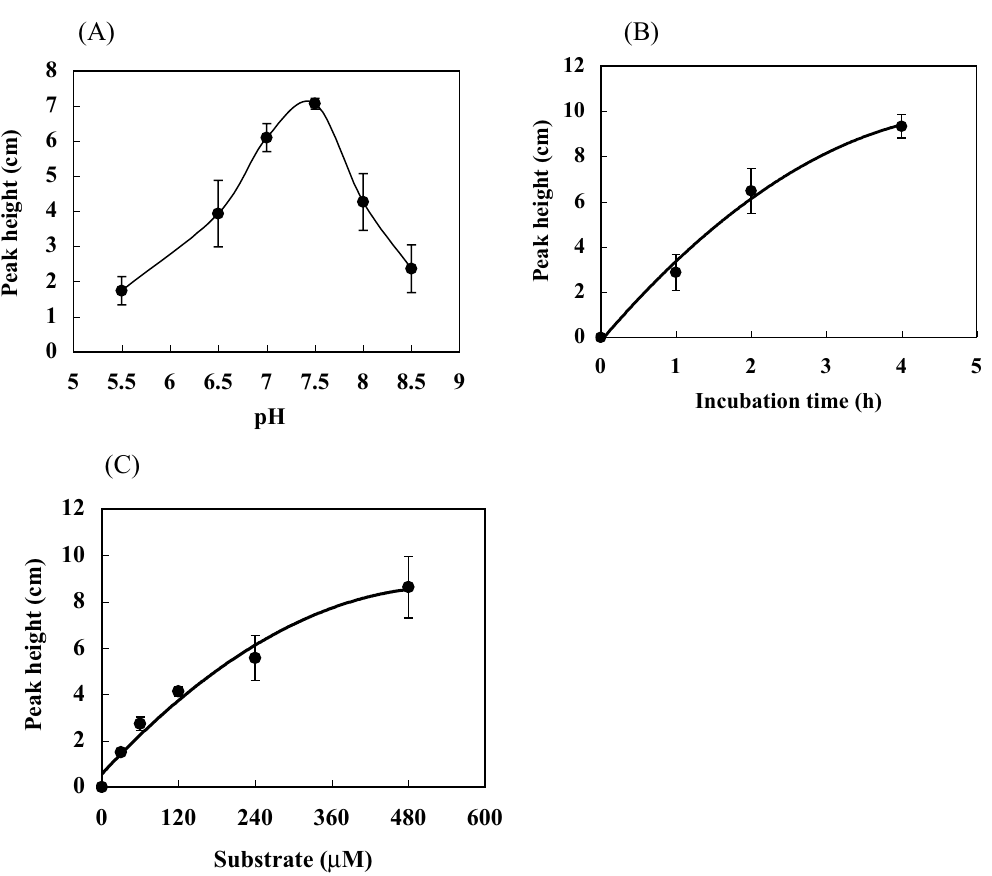
Figure 2. Effects of ( A ) buffer pH, ( B ) incubation time, and ( C ) substrate concentration on HCV-PR